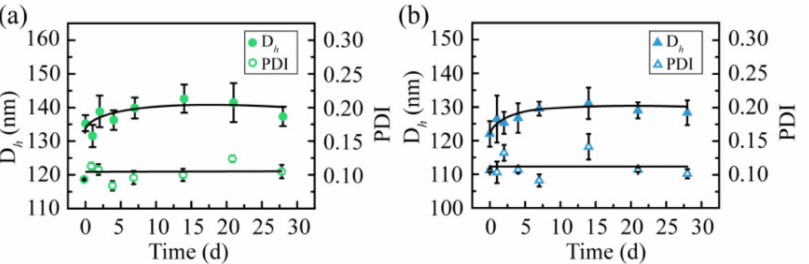
Figure 6. Particle size and polydispersity index of CSL-loaded nanoparticles during storage at 4 ◦ C: CSL-G2 NPs ( a ) and CSL-G2-C18 NPs ( b ), n = 3.